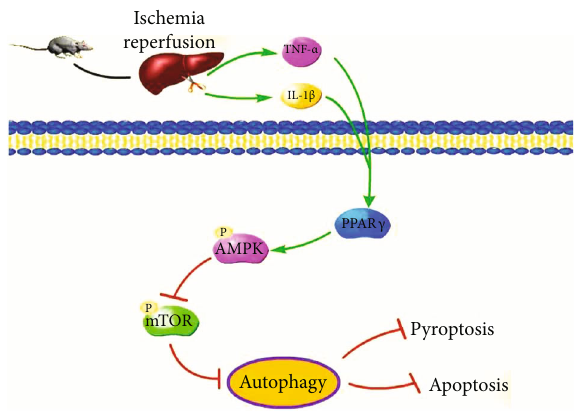
Figure 6: The underlying mechanism of PPAR γ in IR injury. Notes: activated PPAR γ in IR promoted AMPK phosphorylation and inhibited the phosphorylated form of mTOR, which contributed to the suppression of autophagy in mouse livers. And thus, PPAR γ exhibited its protective e ff ects in the hepatic IR